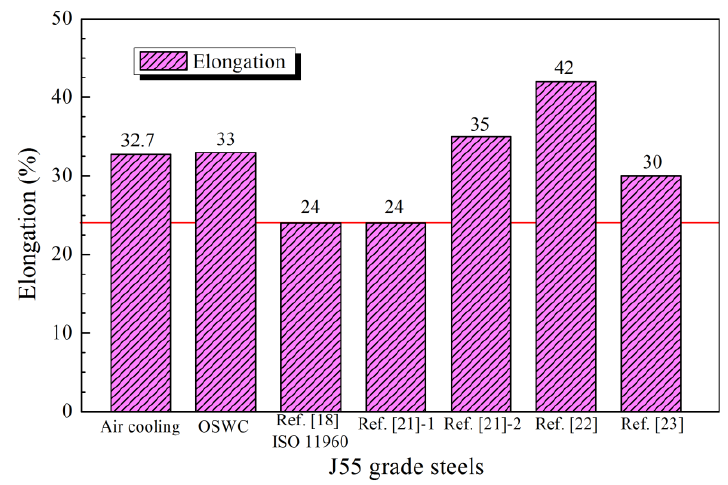
Figure 11. Elongations of different J55-grade steels reported in the literature.